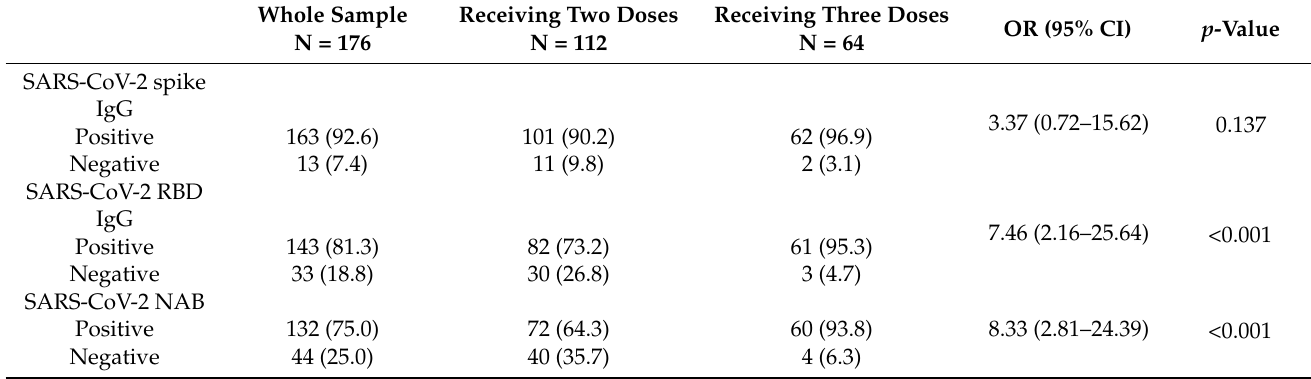
Table 2. Frequency of immune level of antibodies in groups of 2 and 3 doses of COVID-19